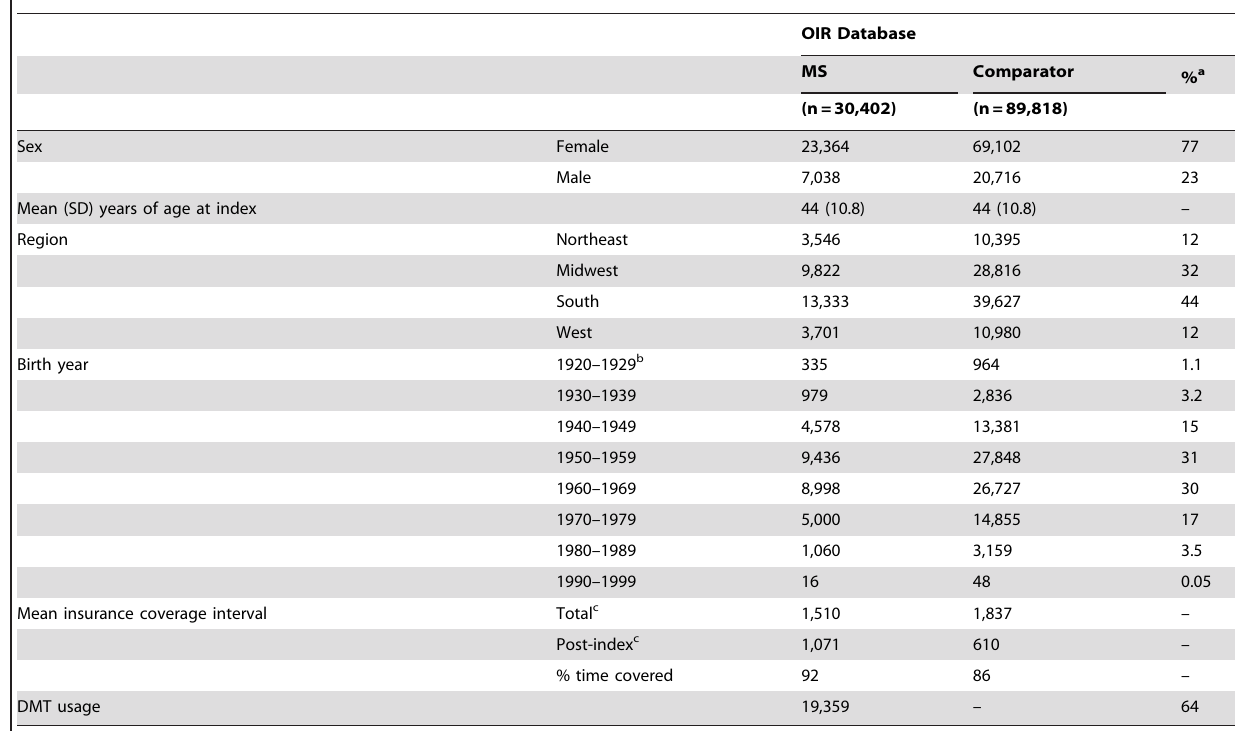
Table 1. Distribution of patients with MS and non-MS